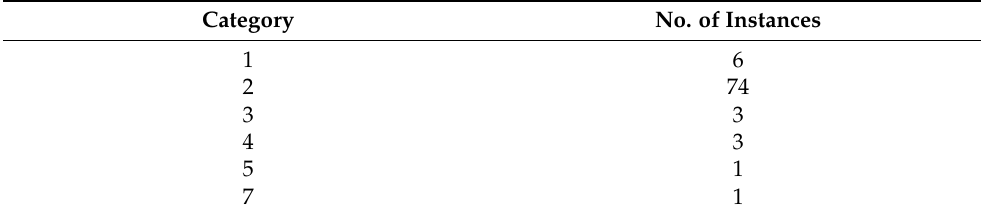
Table 2. The number of instances for each incident category.